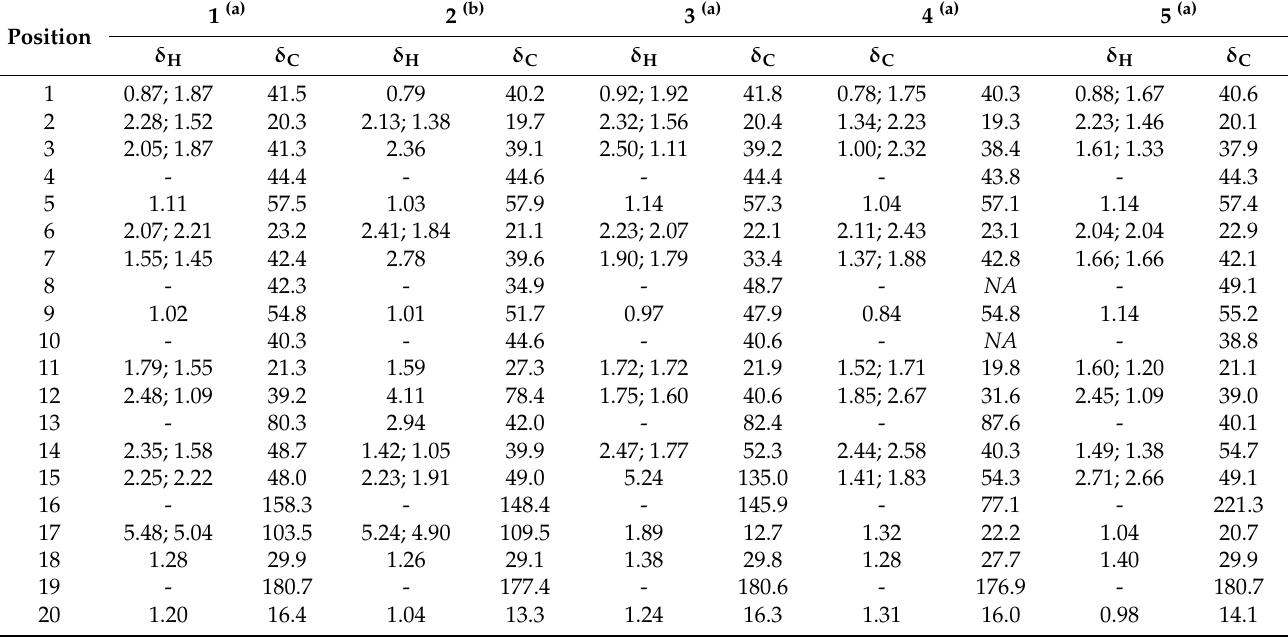
Figure 6. Comparison of the 13 C-NMR of isosteviol ( A ), steviol ( B ) and endocyclic steviol isomer ( C ). Table 4. 1 H and 13 C chemical shifts of the compounds 1 – 9 .